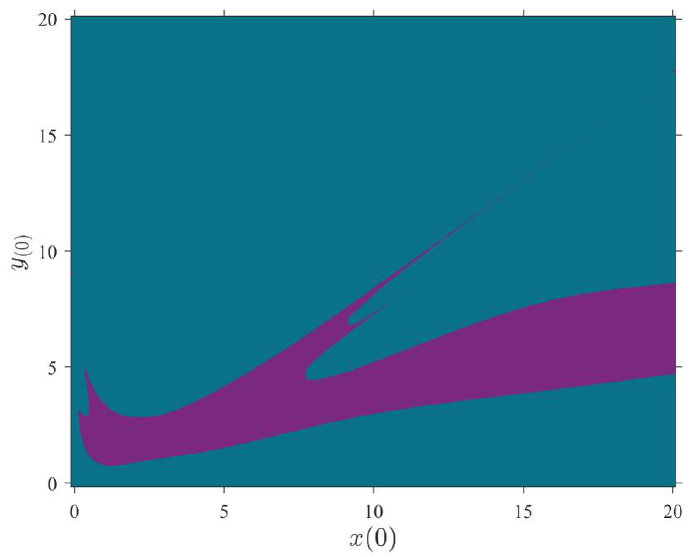
Figure 5. Basin of attraction of 3D-MCM in the x - y plane for φ ( 0 ) = 0.2. Choosing the initial conditions ( x ( 0 ) , y ( 0 ) , 0.2 ) in the purple region makes the system oscillate chaotically, and the ones in the blue area lead to quiescence. The system parameters are mentioned in Table 1. Table 2. Comparison of the proposed model with some other memristive neuron